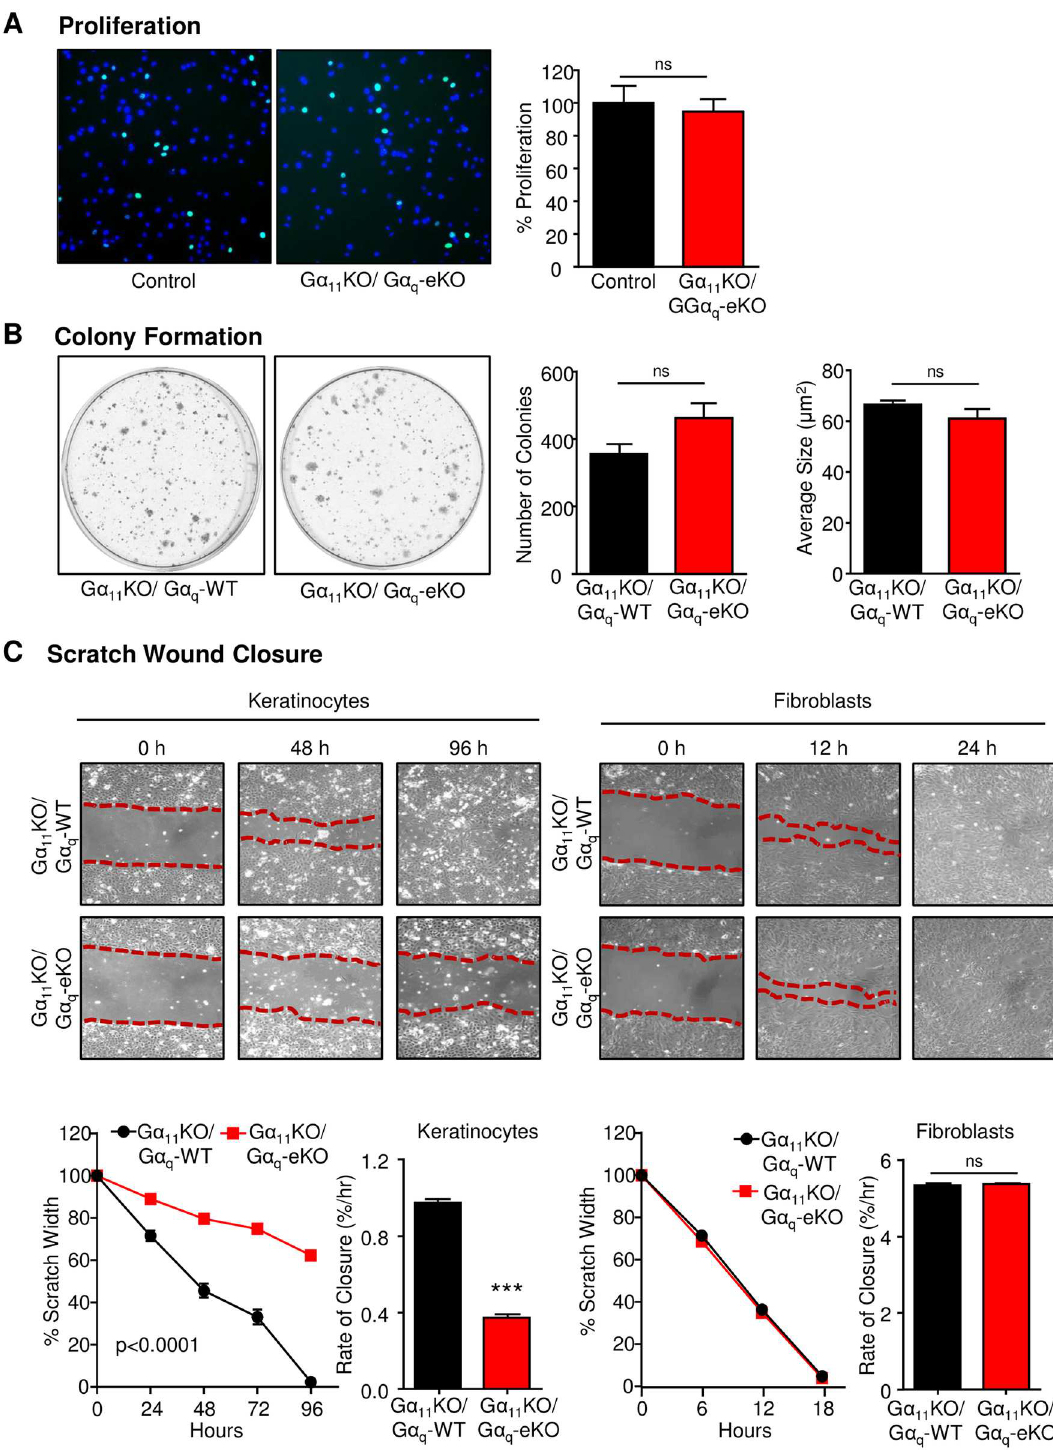
Fig 2. G α 11/q -null keratinocytes have normal proliferative and stem-like phenotypes but demonstrate a significant migratory defect. Keratinocytes from G α 11 KO/G α q -WT control and G α 11 KO/G α q -eKO animalswere assayed for proliferation (A), colony formation (B) and scratch woundclosure(C). To confirm the migratory defect, keratinocyteand fibroblast woundclosure from G α 11 KO/G α q -WT control and G α 11 KO/G α q -eKO were quantified. Statistical significancewas determinedusing Student’s t-test, * p < 0.05, ** p < 0.01, *** p < 0.001.